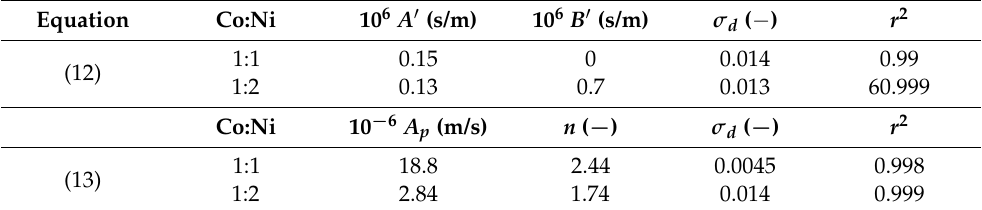
Table 3. Values of constants of Equations (12) and